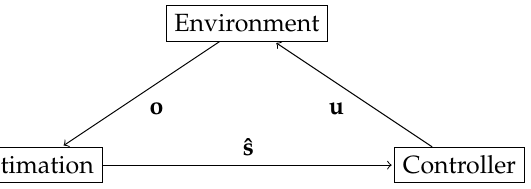
Figure 1. Schematic diagram for our setting, where the three main blocks and their relations are depicted. Note that they relate in a closed loop way, i.e., the controller produces a control u based on the current ˆs that causes a change in the AUV state, according to the environment block that simulates the underwater medium. Hence, the value o observed by the AUV sensors change and the estimation block updates its estimate input to the controller ˆs , and then the whole process starts